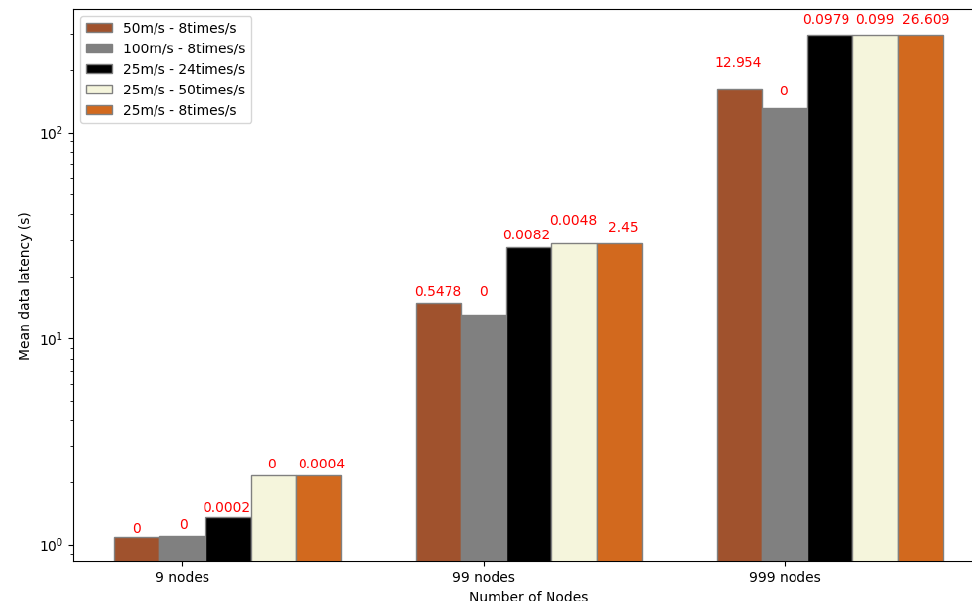
Figure 7. Mean data latency under different simulation scenarios of MOTILO algorithm. Values illustrated with red color corresponds to the average packet